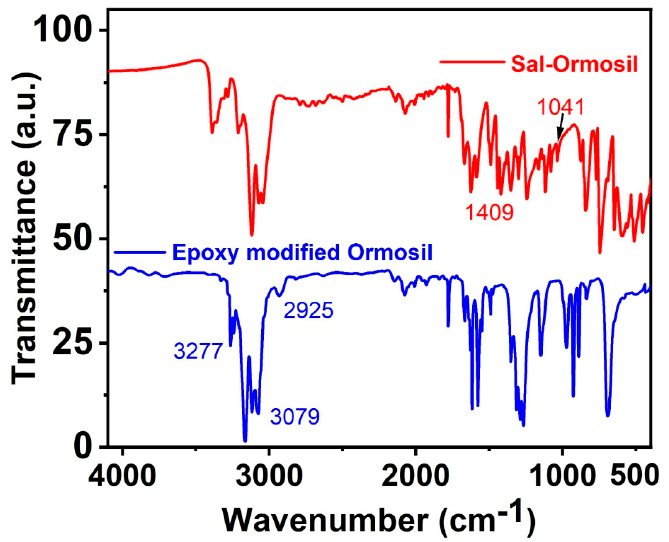
Figure 2. FT-IR of the epoxy-modified ormosil (blue) and the covalent immobilization of salicylamide to the ormosil nanoparticles (red).